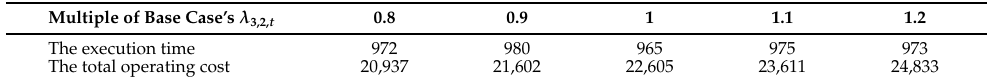
Table 8. The execution time and optimization results in case